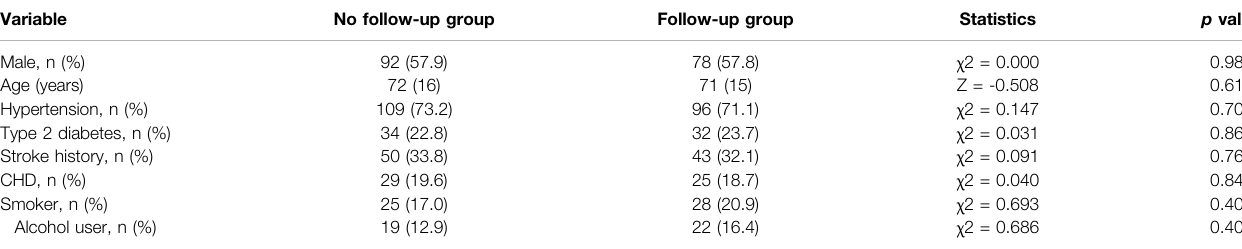
TABLE 1 | The characteristics between no follow-up group and follow-up group. Variable No follow-up group Follow-up group